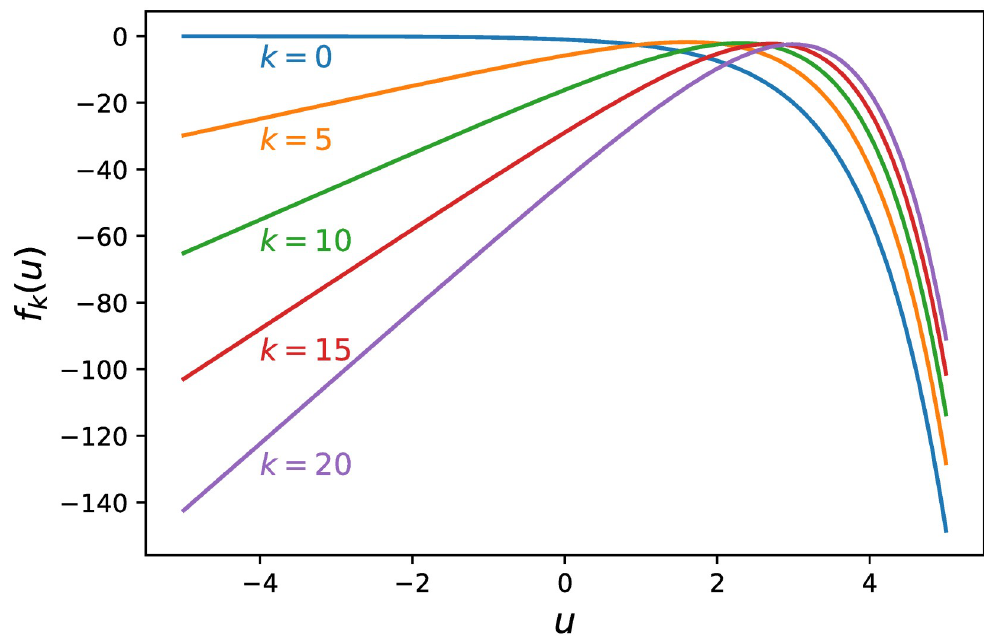
Fig 1. Graphs of f